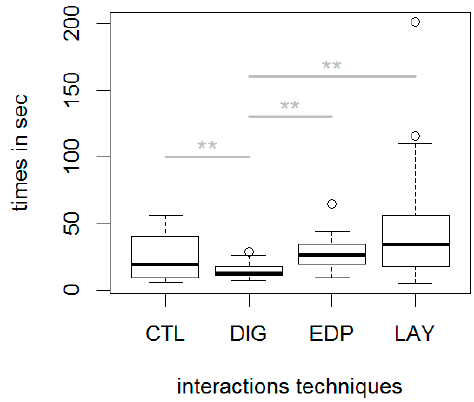
Figure 8. Response time for the Location task per interaction technique. DIG is the quickest interaction technique to find an element. (** P < 0.01).